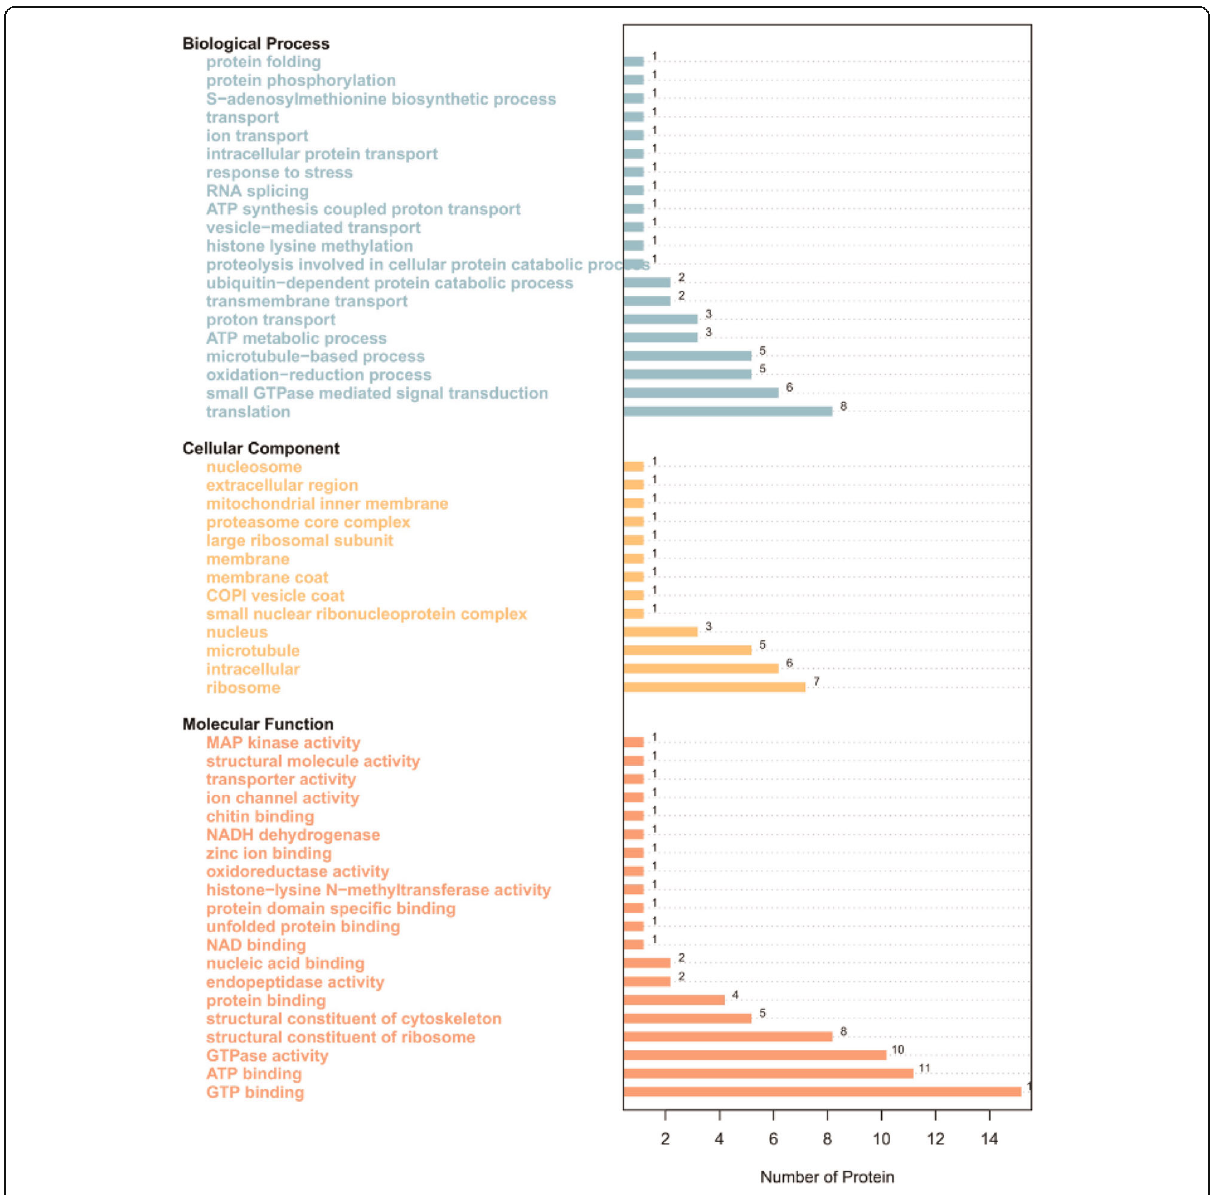
Fig. 7 GO functional annotation of proteins identified in Fraction